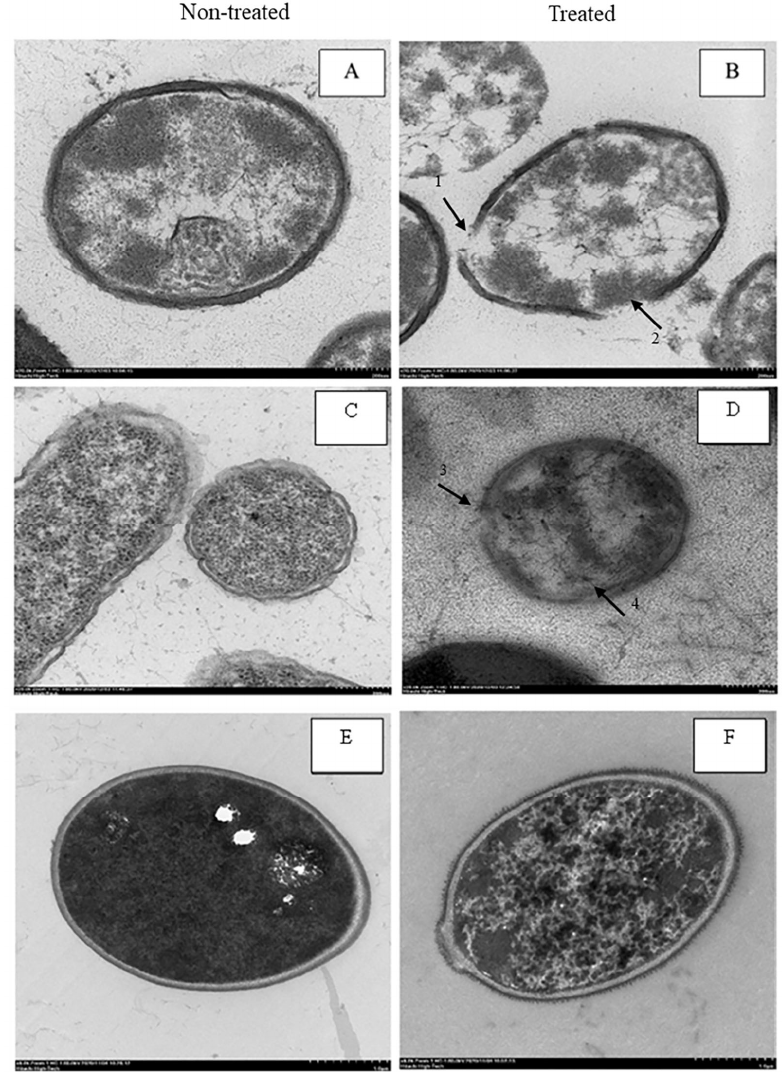
Figure 2. Transmission electron micrographs of non-treated B. cereus ( A ), E. aerogenes ( C ) and C. tropicalis ( E ) at 20,000×, 20,000× and 6000× magni fi cation, respectively. The e ff ect of 15:20% ( w/v ) salt/acid solution for 10 min on the microbial structure of B. cereus ( B ), A. aerogenes ( D ) and C. tropi- calis ( F ) at 20,000×, 20,000× and 6000× magni fi cation, respectively. Holes on cell surface (arrow #1, arrow #2 and arrow #3) and separation of cell membrane from cell wall (arrow #4).